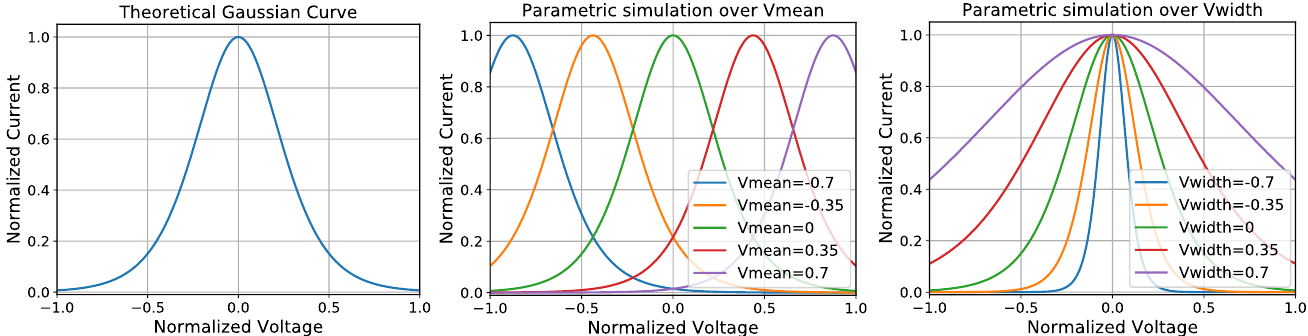
Figure 23. Theoretical output function of an example of a floating gate based circuit ( left ) Simulation for V mean = 0 and V width = 0 ( center ) Parametric simulation over V mean for V width = 0 ( right ) Parametric simulation over V width for V mean =